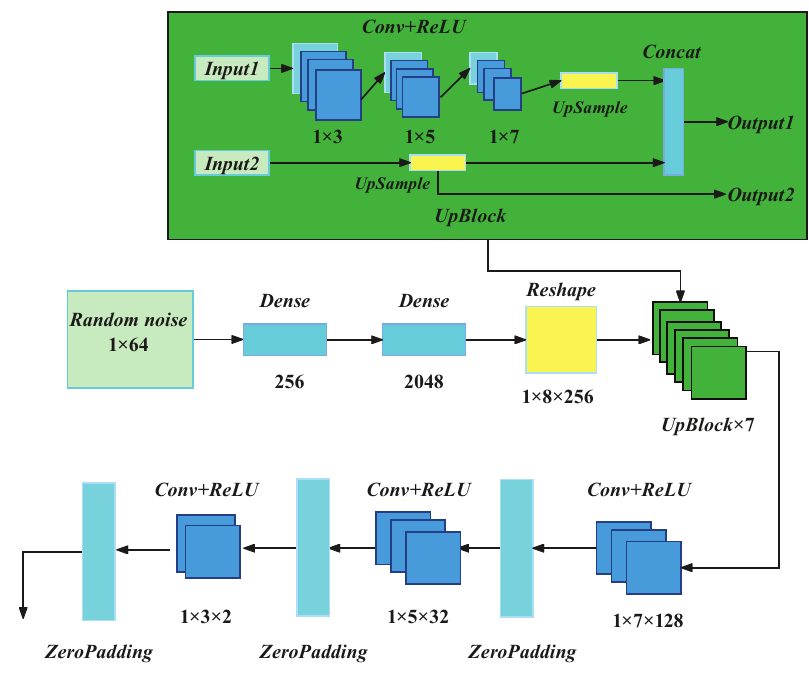
Figure 4. The architecture of the generator